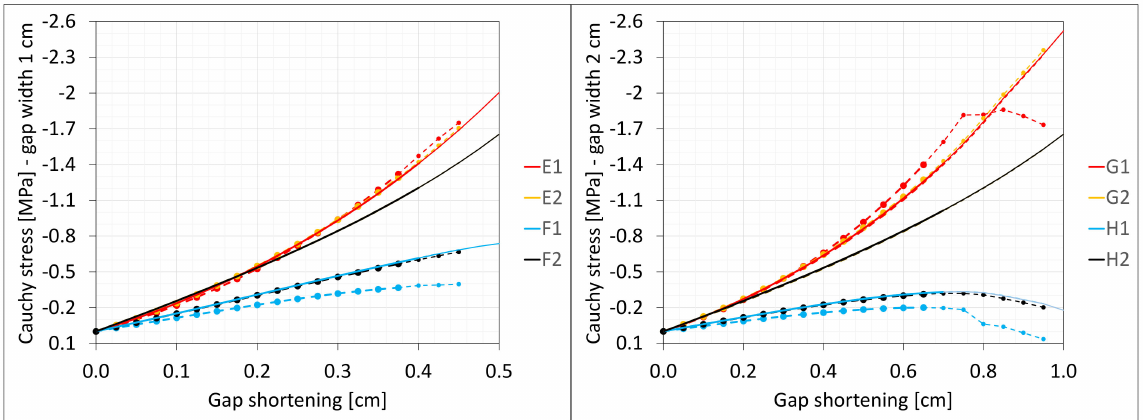
Figure 21. Equilibrium paths for stresses σ z in selected nodes. The width of the gap is equal to 1.0 cm, left graphic, and 2.0 cm, right graphic. Plane strain models, solid lines; and 3D models, dashed lines (curves from Figure 6). Parts of charts with non-physical deformations are displayed with thin lines.